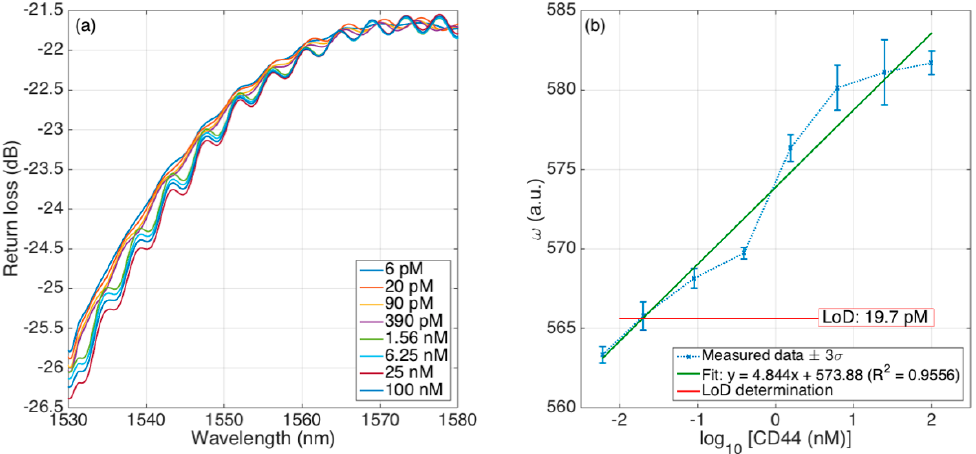
Figure 7. Detection of CD44 protein with a biofunctionalized gold-coated ball resonator. ( a ) The reflection spectrum of the ball resonator for different CD44 concentrations, ranging from 6 pM to 100 nM; ( b ) KLT response for each concentration, reporting the standard deviation of data acquired over 10 min, the log − linear fit, and the LoD determination.